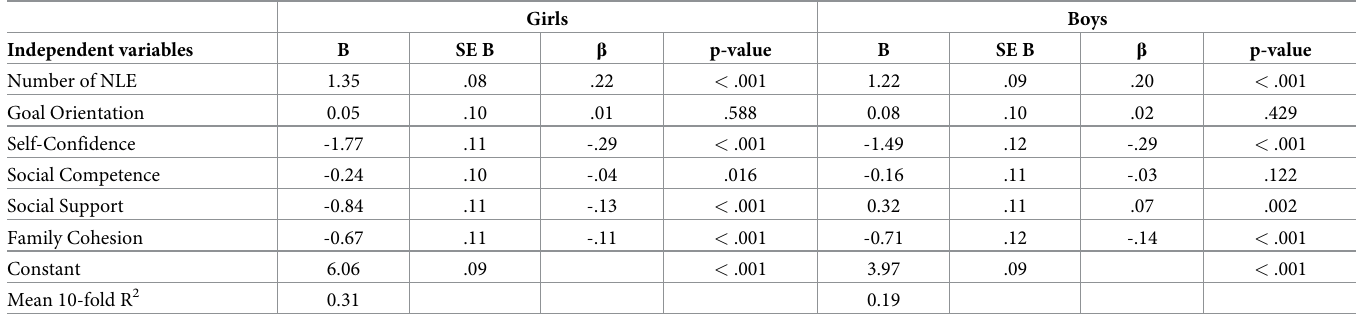
Table 4. Regression of negative life events and protective factors as predictors of symptoms of